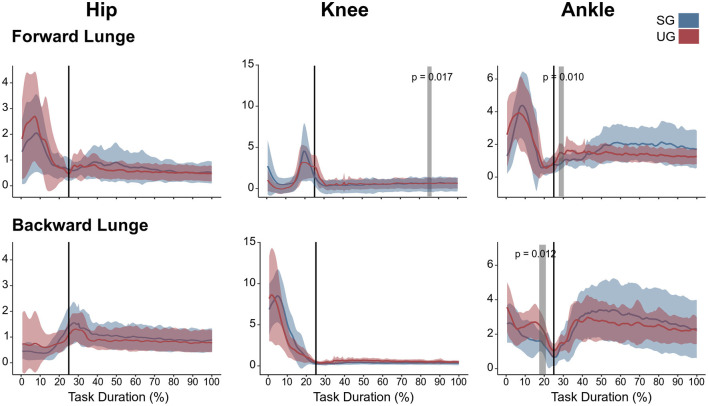
Lower limb coactivation ratios (antagonist mean/agonist mean) of the forward and backward lunges from lift-off until steady state. Each panel show the mean values and standard deviation bands for the hip, knee and ankle joint coactivation index for the stable (SG—blue) and unstable ground condition (UG—red). Gray bands denote significant differences from the statistical parametrical mapping difference estimator. Both panels are presented in a time normalized base, vertical lines represent touchdown.